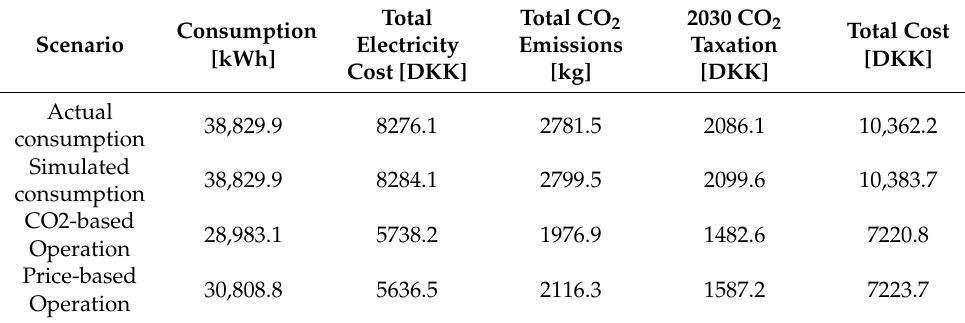
Table 11. Comparison of scenario